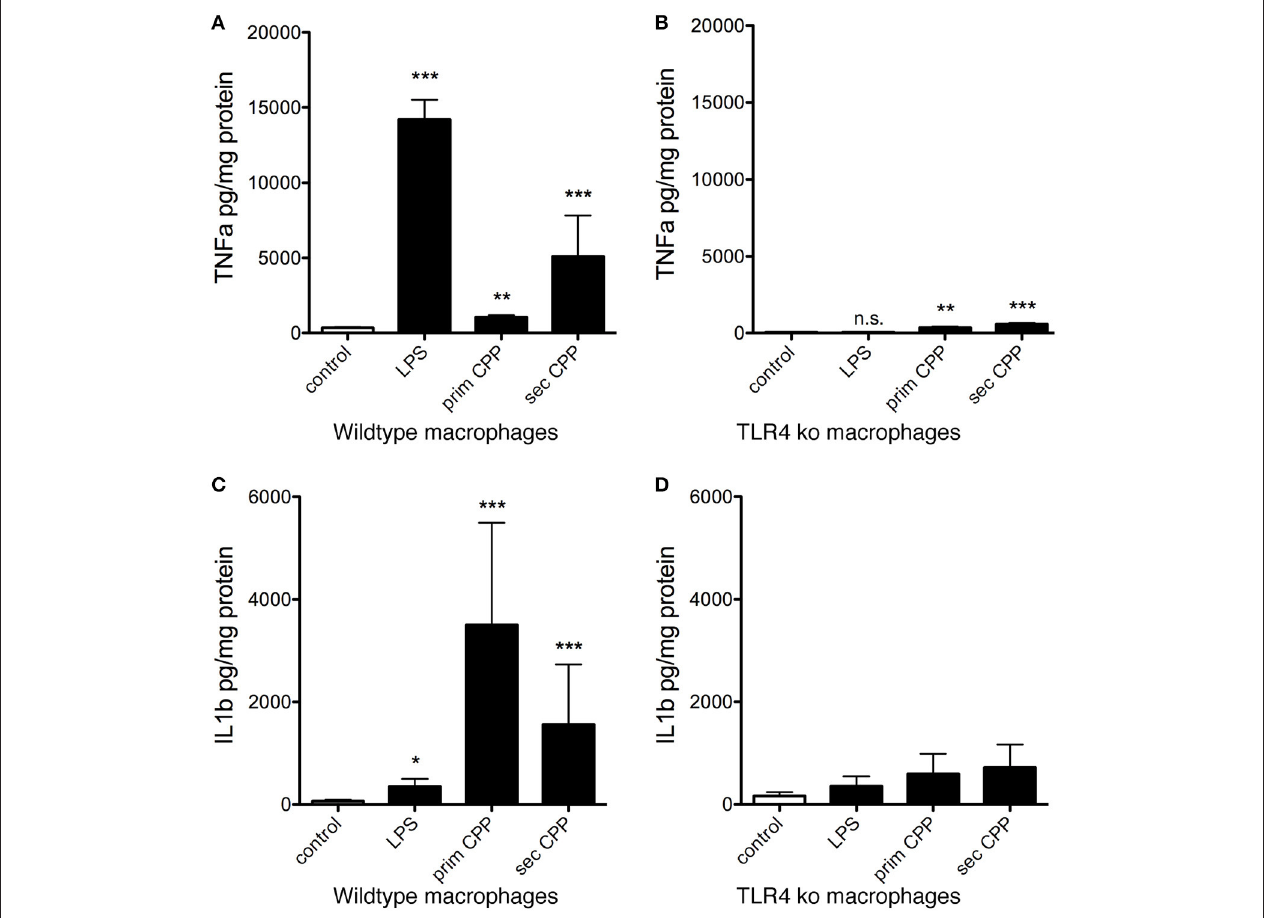
FIGURE 8 | CPP-induced inflammatory cytokine secretion by macrophages is TLR4 dependent. Serum-starved wildtype and TLR4-deficient macrophages (TLR ko) where treated with LPS, primary or secondary CPP. (A,B) After 6h stimulation, inflammatory cytokine TNF α secretion was determined in culture supernatants by ELISA. Secondary CPP caused stronger TNF α secretion than primary CPP. TLR4 ko macrophages showed 10-fold reduced TNF α secretion compared to wildtype macrophages suggesting a major contribution of TLR4 signaling in CPP-triggered TNF α secretion. Nevertheless, CPP-stimulated TLR4 ko still secreted higher amounts of TNF α compared to untreated control (prim CPP p < 0.01, sec CPP p < 0.001) suggesting a minor contribution to overall TNF α secretion of a TLR4-independent pathway. (C,D) After 16h stimulation, supernatant IL-1 β secreted by LPS-primed wildtype macrophages treated with primary CPP was twice